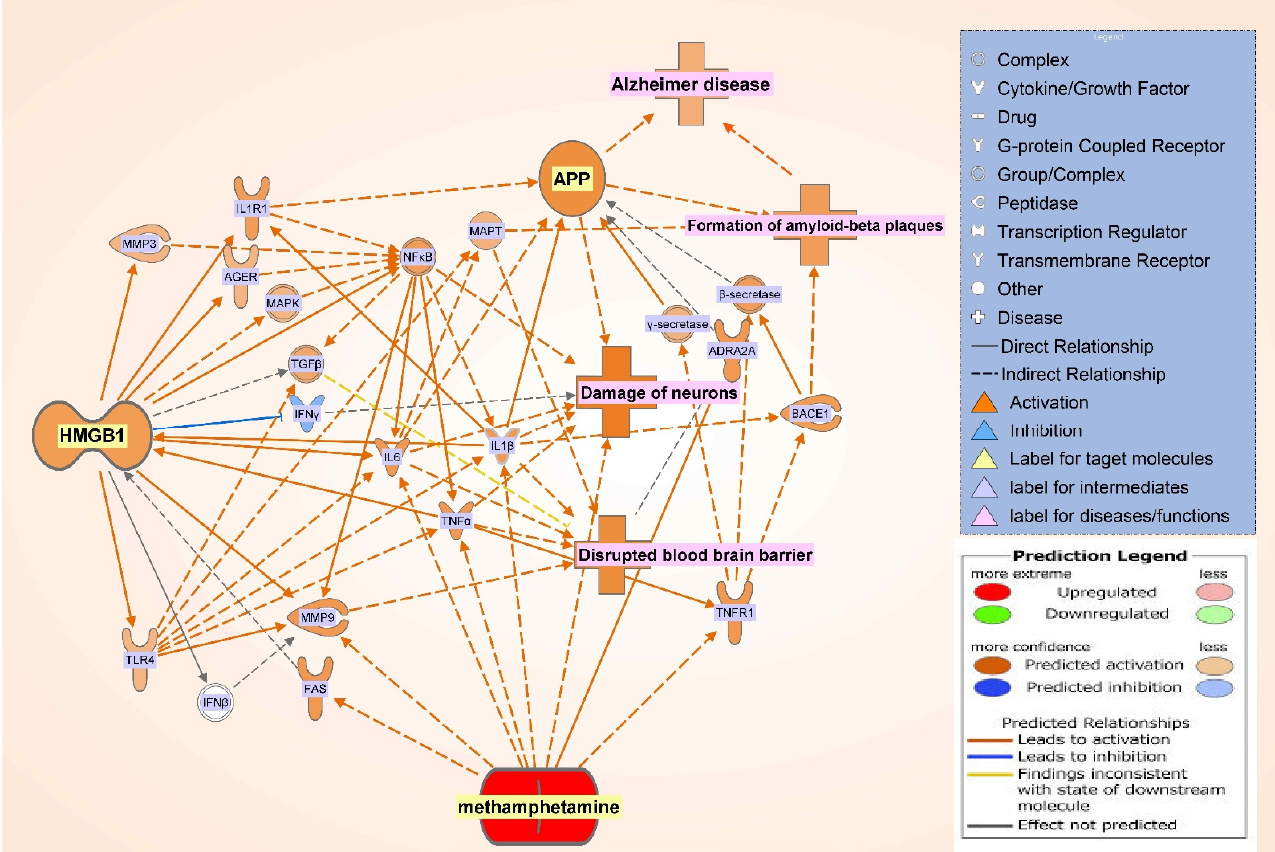
Figure 10. Canonical pathways of the METH, HMGB1, and APP integrated network. The core analysis of the integrated pathway revealed the canonical pathways associated with the network in order of decreasing − log( p- value), of which neuroinflammation signaling pathway was the top and selected for further investigation.